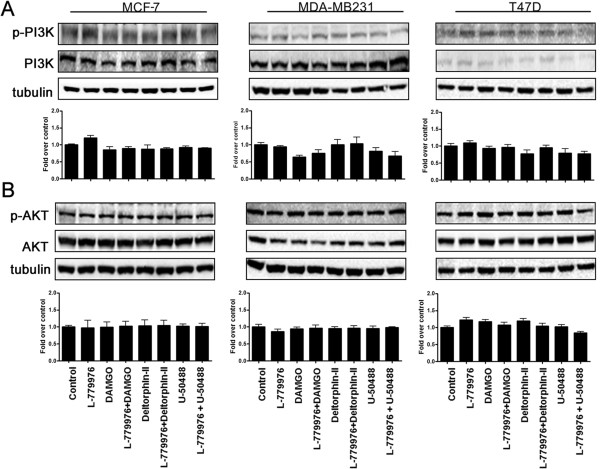
Activation of SSTR2 and ORs modulate PI3K/AKT cell survival pathway. Representative western blots illustrating the changes in the expression of PI3K (A) and AKT (B) in MCF-7, MDA-MB231 and T47D cells. Activation of SSTR2 and ORs individually or simultaneously exhibited no discernible changes in phosphorylation of PI3K and AKT, thus maintaining the status of PI3K/AKT at control levels. Bar graphs represent the densitometric analysis of PI3K/AKT expression in different tumor cells. The data presented are a representation of triplicate experiments.